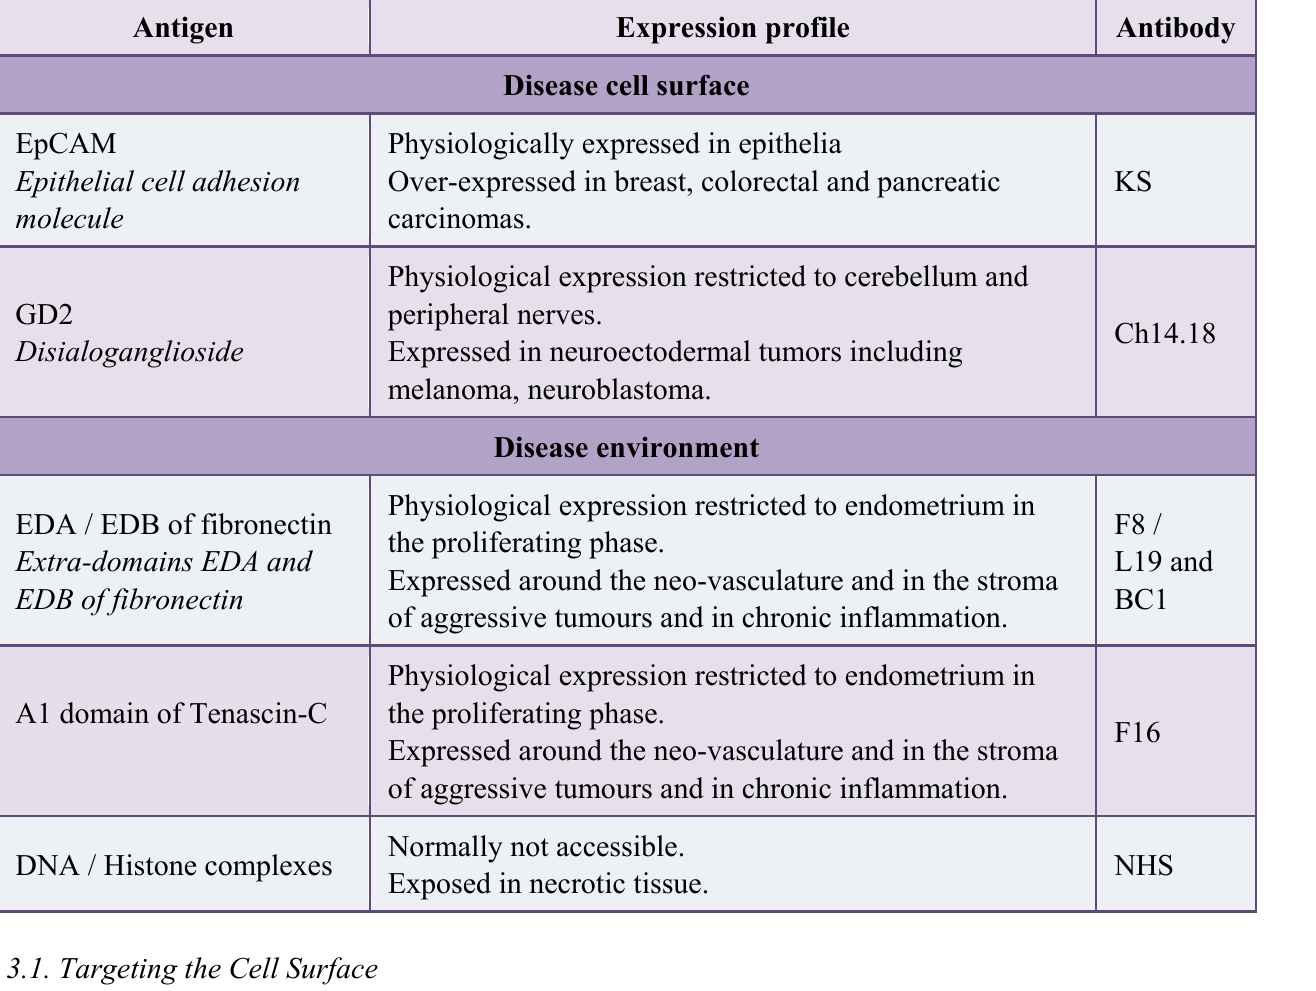
Table 1. Targets of the most advanced